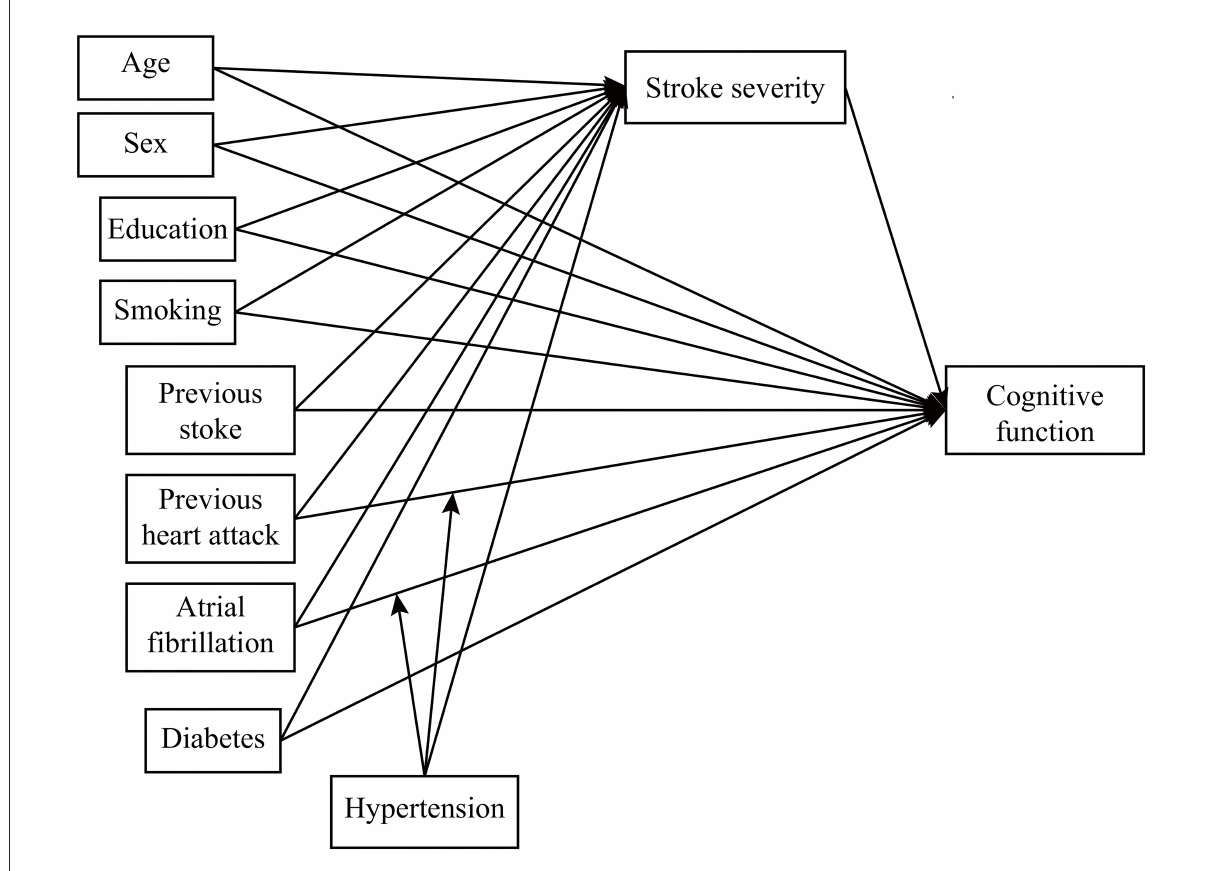
FIGURE2 The final diagram of the moderated and mediation